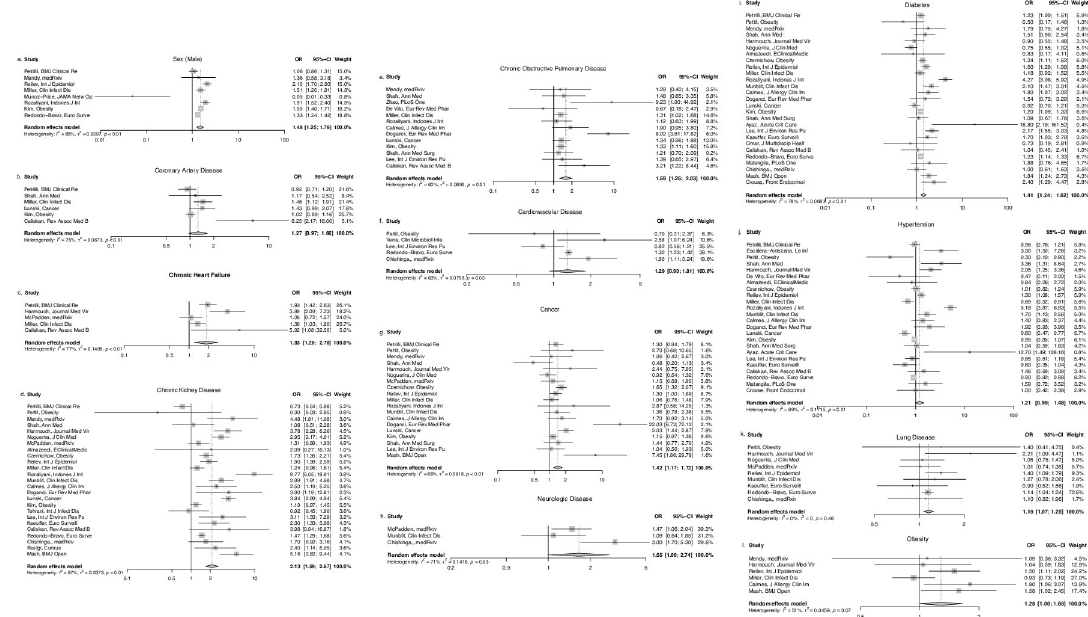
Fig 2. a-l. Forest plots for individual study estimates and pooled estimates of risk factors associated with COVID-19 related mortality in studies using logistic